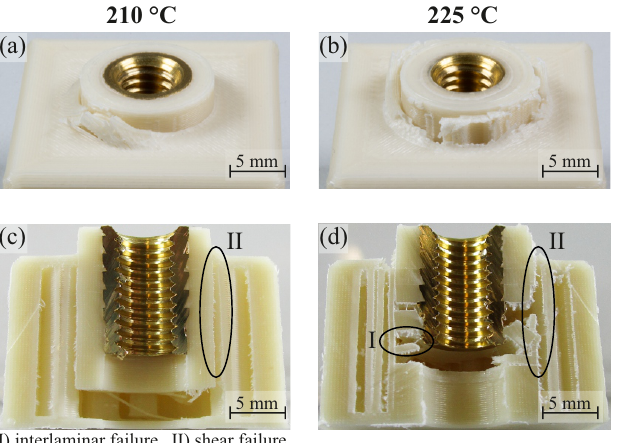
Figure 17. Exemplary test specimens of the test series with varying nozzle temperature: top view ( a , b ) and sectional view ( c , d